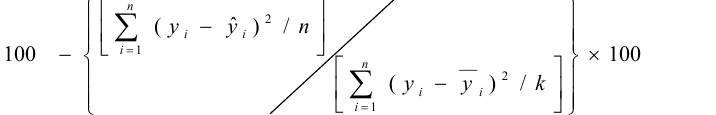
Table 14 . Results of R 2 , REP%, RMSEP and Q 2 for prediction set of GA-PLS study are also reported